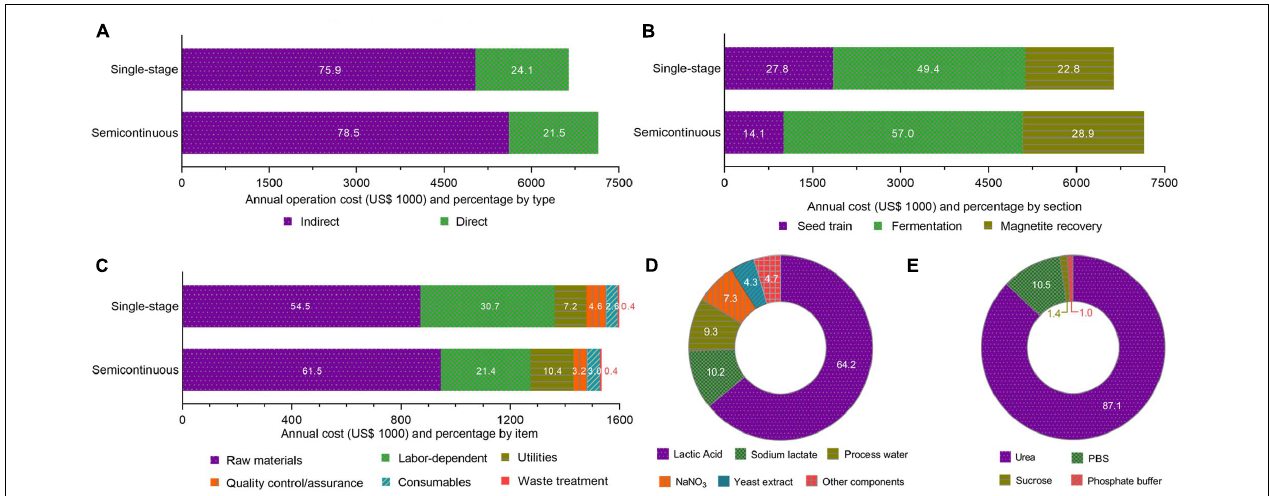
FIGURE 4 | Annual operating costs composition breakdowns. Single-stage and semicontinuous cultivation cost contributions from direct and indirect costs (A) and process sections (B) . Direct operating costs breakdown showing cost types (C) . Material costs compositions from fermentation (D) and downstream sections (E) .